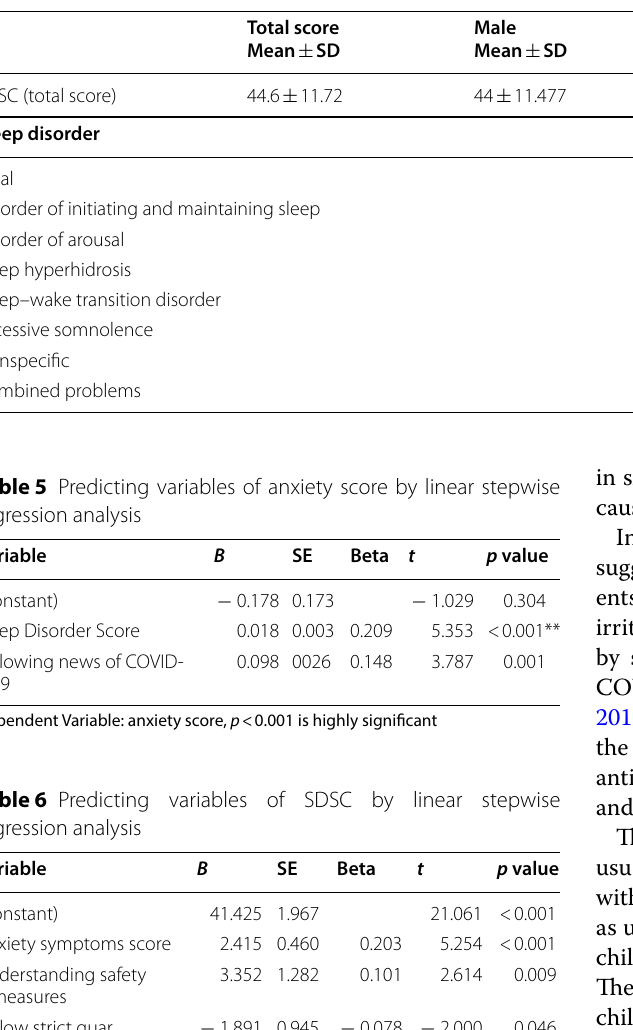
Table 4 Sleep disorder scale total score and sleep disorder types in participants